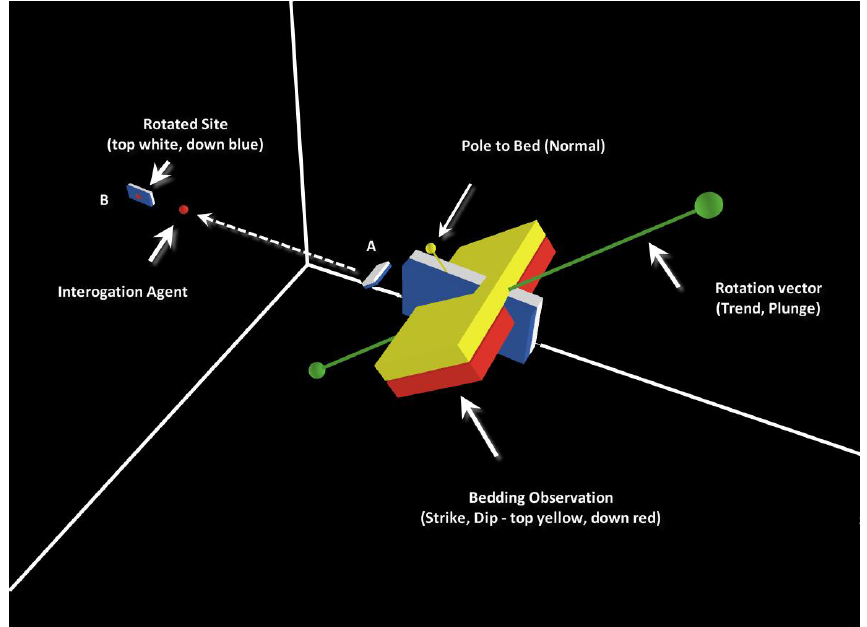
Figure 3. Structural agent demonstrating a quaternion 90 ◦ clockwise rotation during linear estimation (SLERP) between two points. Starting point A (local), with equivalent orientation to the larger observation (yellow and red cuboid) and final rotated point B (distal). Rotation maintains smooth topology for top direction. See Appendix B for